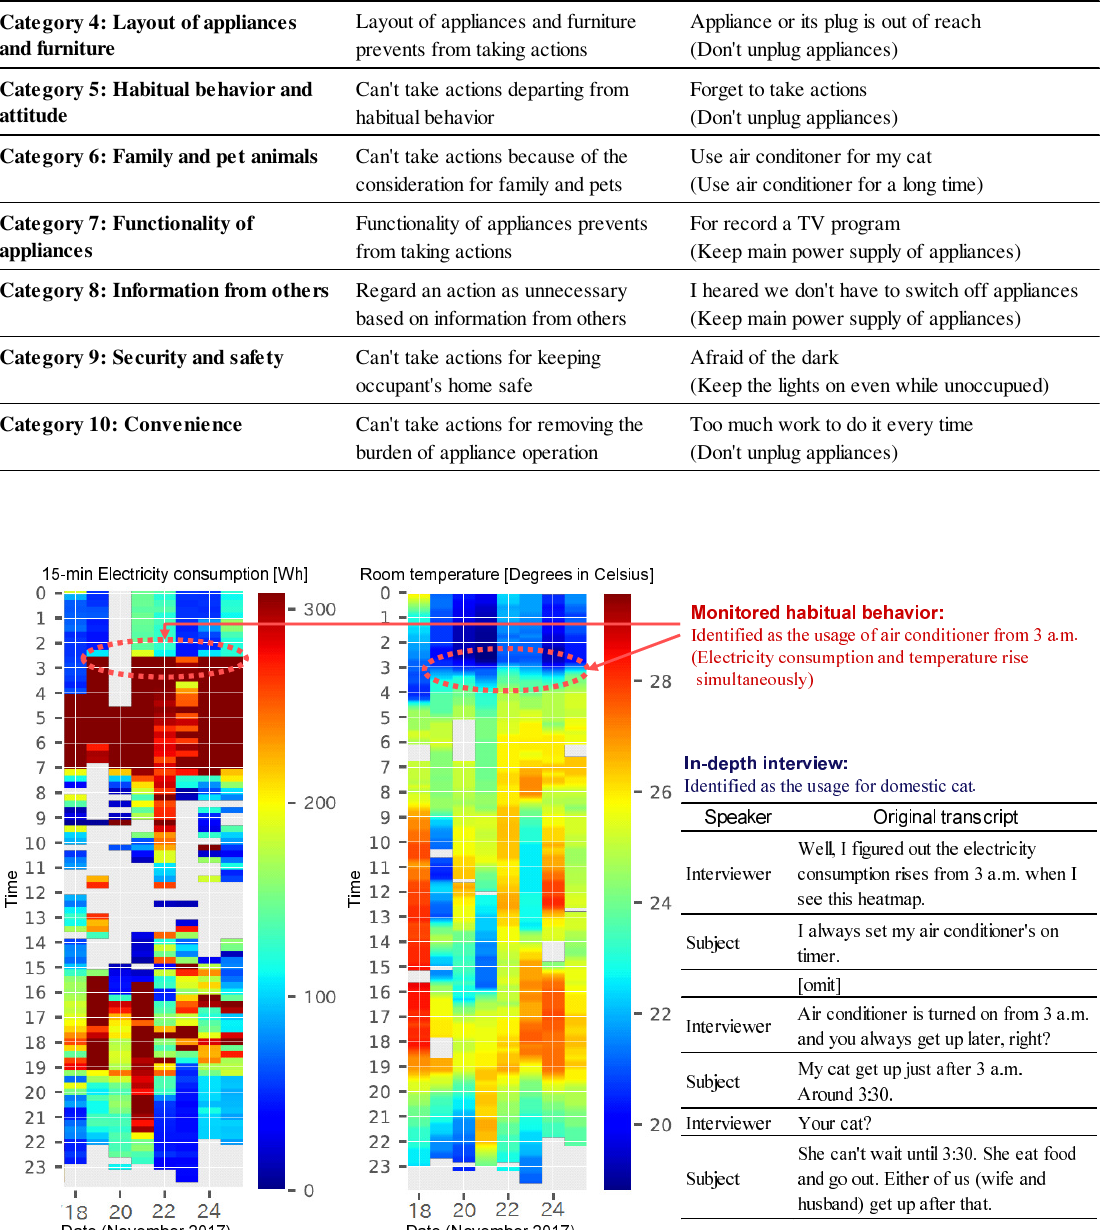
Figure 4. A example of an in-depth interview employing visualized sensor